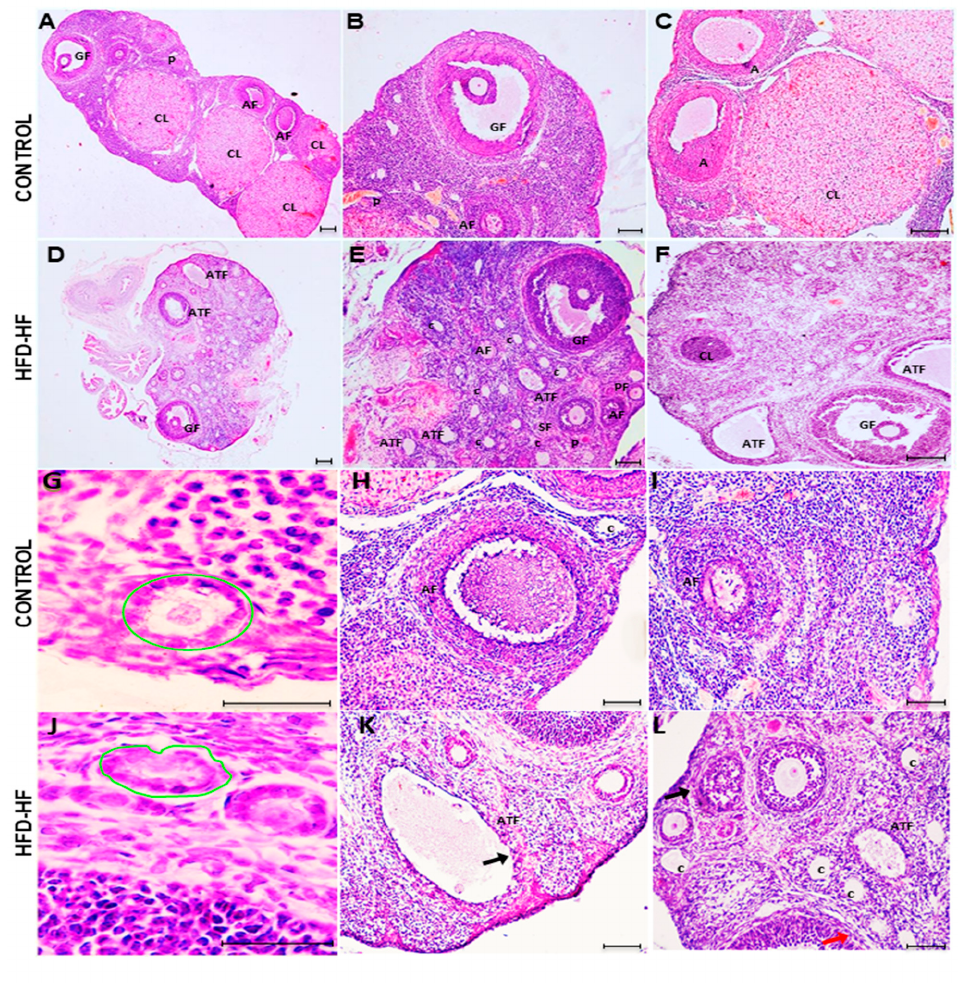
(Figure 4D–F). The HFD-HF diet increased the immunostaining of ER α protein in the ante- rior pituitary as well, compared to the control rats (Figure 4G–I), whereas P450 aromatase showed a significant reduction ( p ≤ 0.05) (Figure 4J–L). An intense immunopositivity of inhibin β was observed in the anterior pituitary cells of the HFD-HF diet-fed rats as compared to control rats (Figure 4M–O). A decreased expression of progesterone receptor (PR) was observed in rats fed on the HFD-HF diet, compared to the control (Figure 4P–R). The prolactin receptor (PRLR) in the anterior pituitary of the rats subjected to the HFD-HF Cells 2022 , 11 , x FOR PEER REVIEW diet exhibited increased intensity ( p ≤ 0.05), compared to the control (Figure 4S–U).